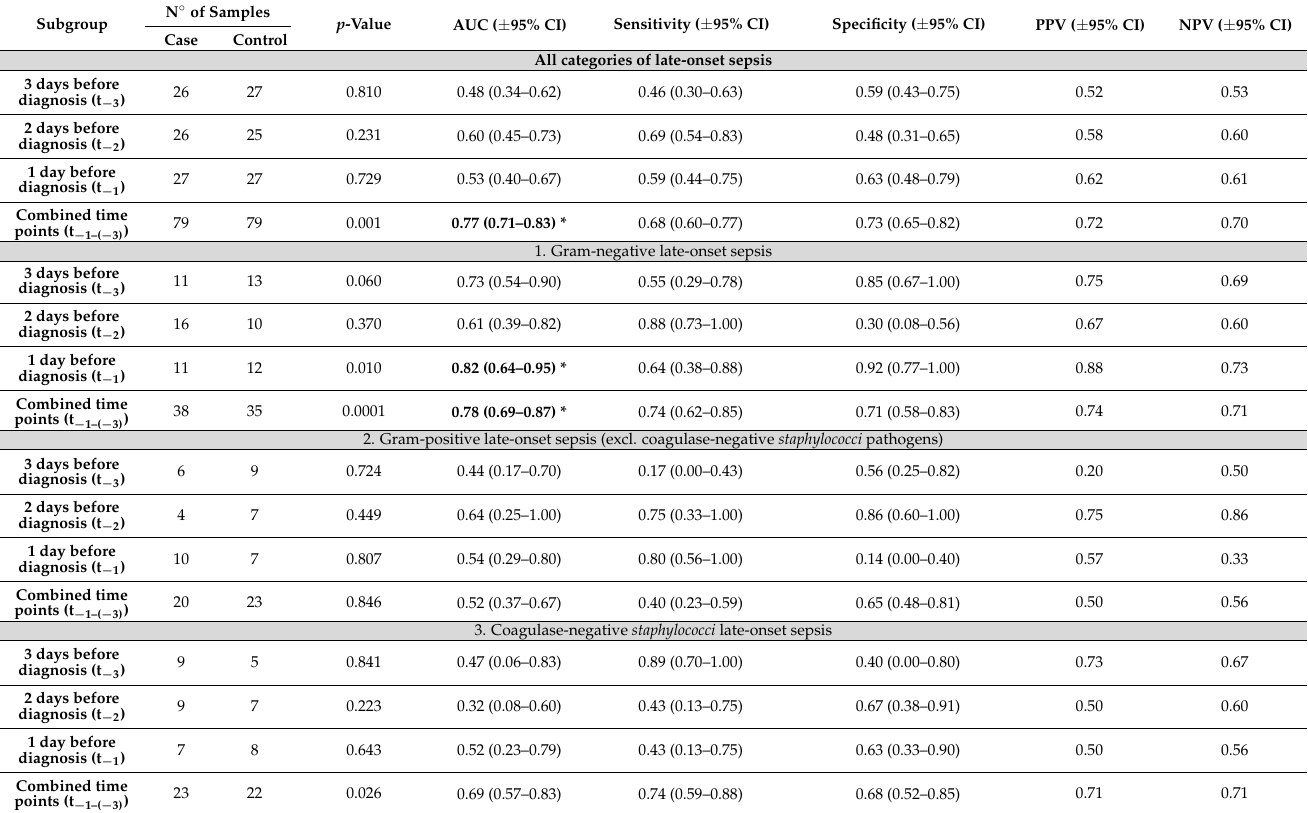
Table 3. Performance characteristics of gas chromatography—time of flight—mass spectrometry, as analyzed using random forest classification.